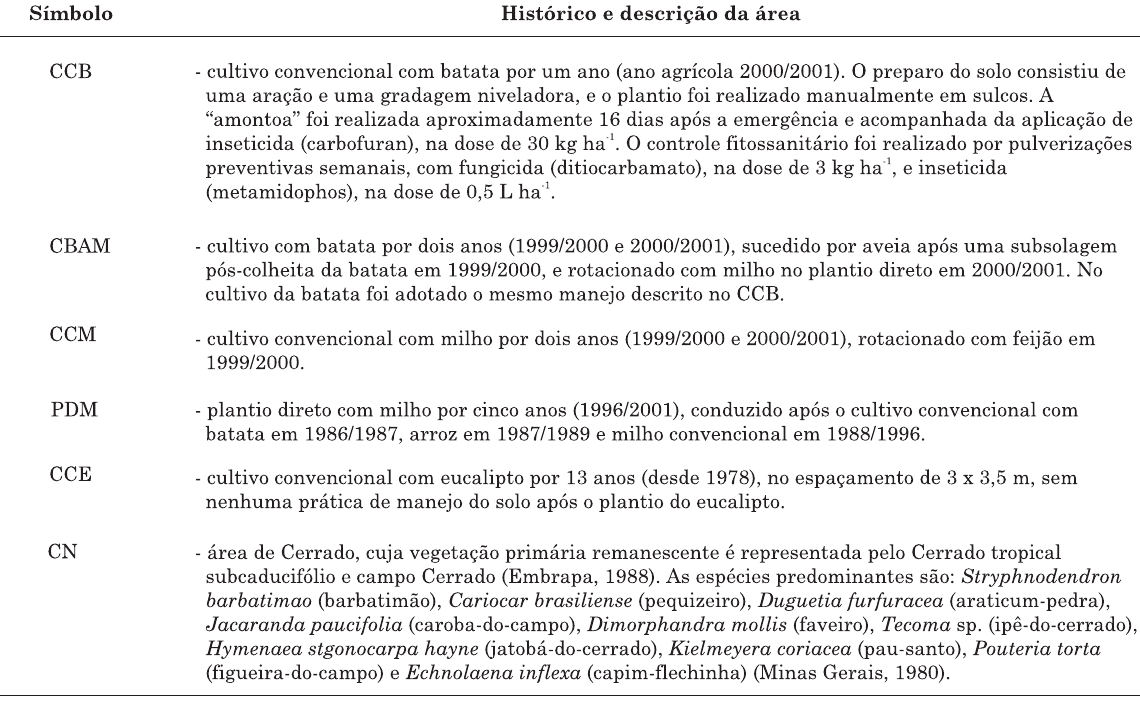
Cmic/C orgânico (Cmic/CO) em Latossolo